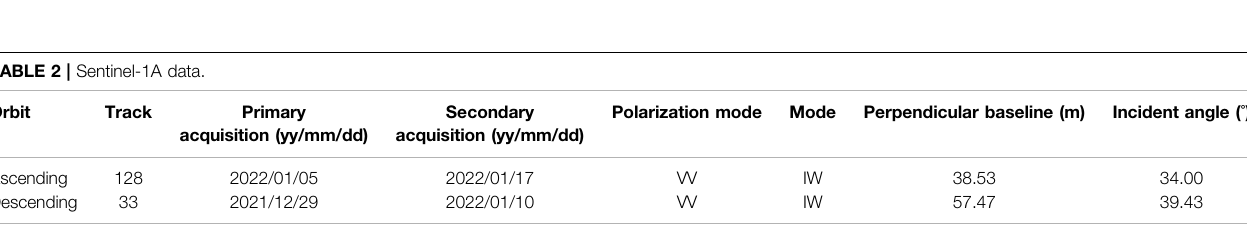
TABLE 2 | Sentinel-1A